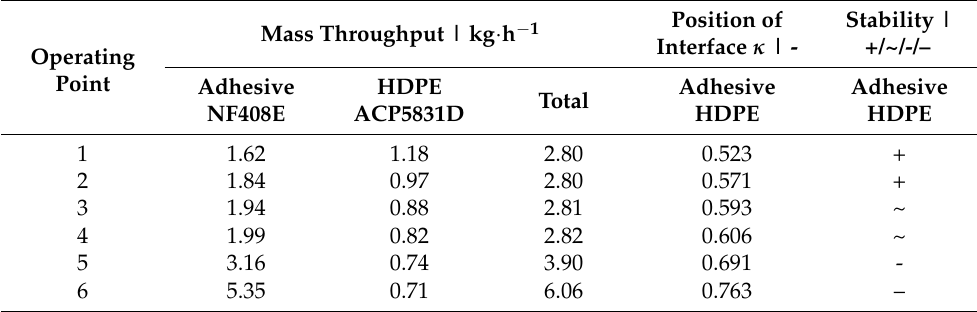
Table 7. Overview of mass throughputs, dimensionless position of the interface, and visual assess- ment of flow instabilities of the co-extrudate for the operating points under investigation.